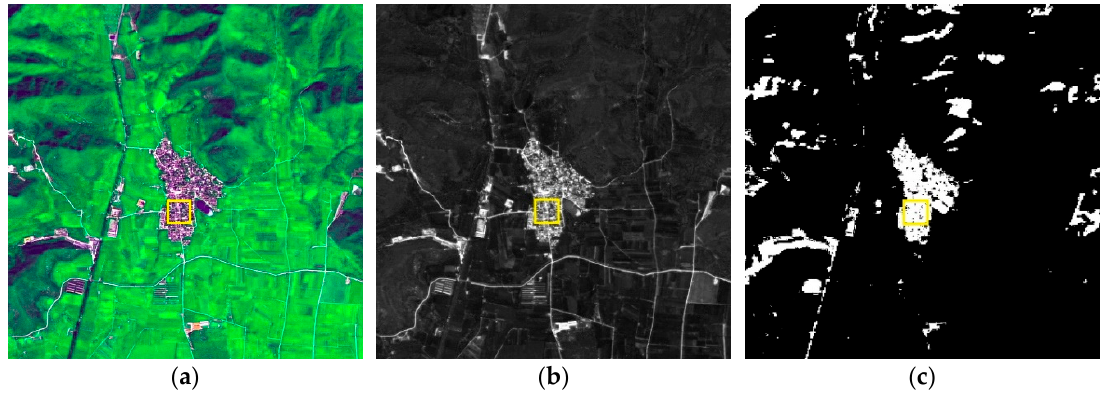
Figure 3. An image with its different representations in two color spaces. ( a ) Color image; ( b ) R channel; ( c ) a channel.